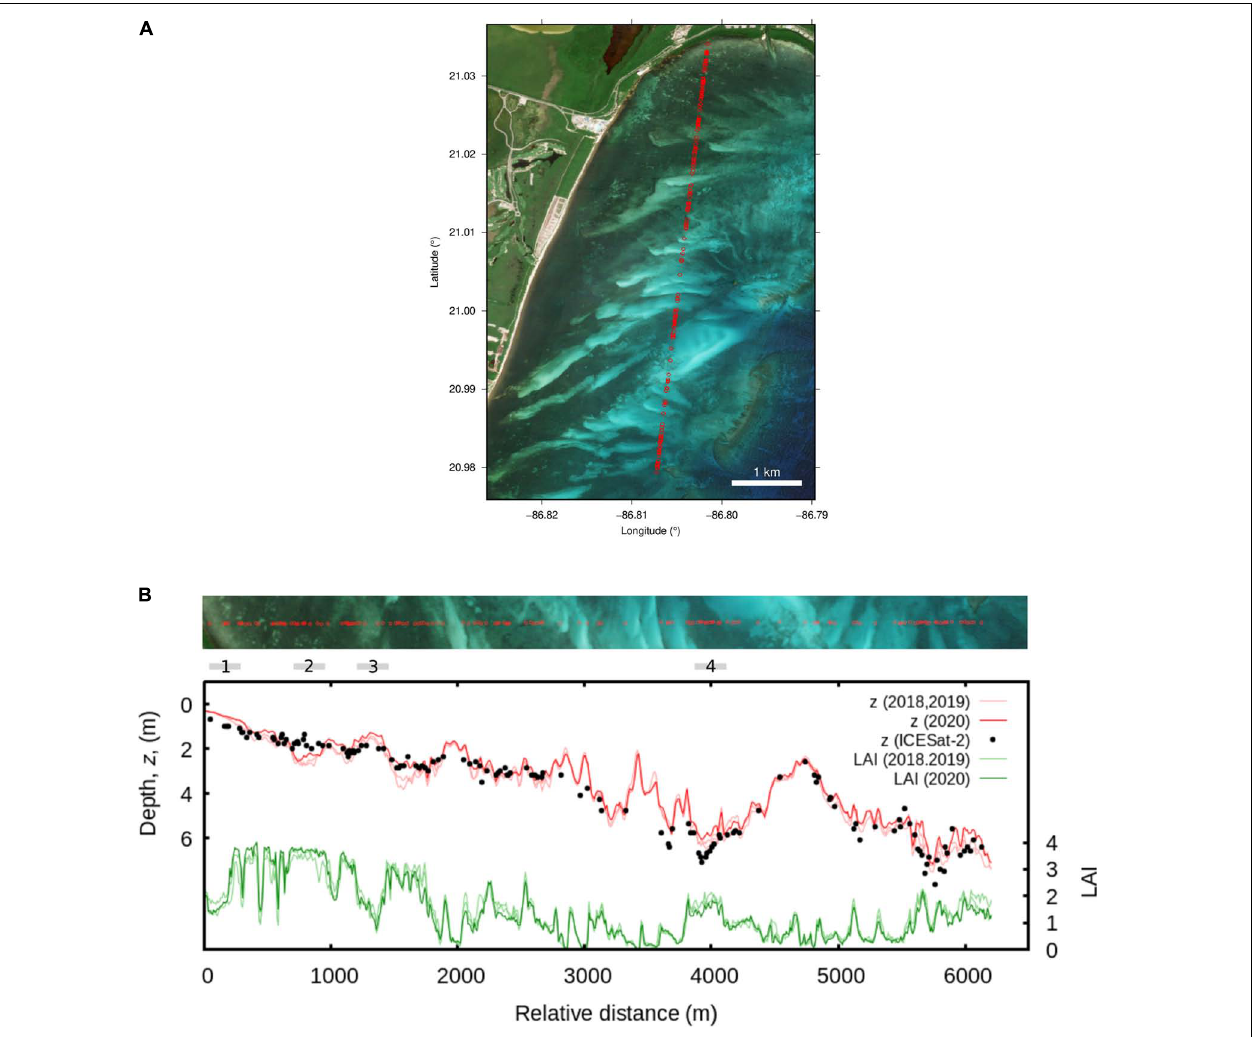
FIGURE 8 | (A) Transect of ICESat-2 data points from 2 February 2020, n = 140. (B) Plot along transect starting at the top of (A) showing depth from image analysis ( z , red) and ICESat-2 data (dots), and estimated LAI (green). Dark red and dark green lines are estimates from the 2020 image median, 2018 and 2019 image medians are also shown as lighter coloured lines. Sections indicated by “1” to “4” are referred to in the text.